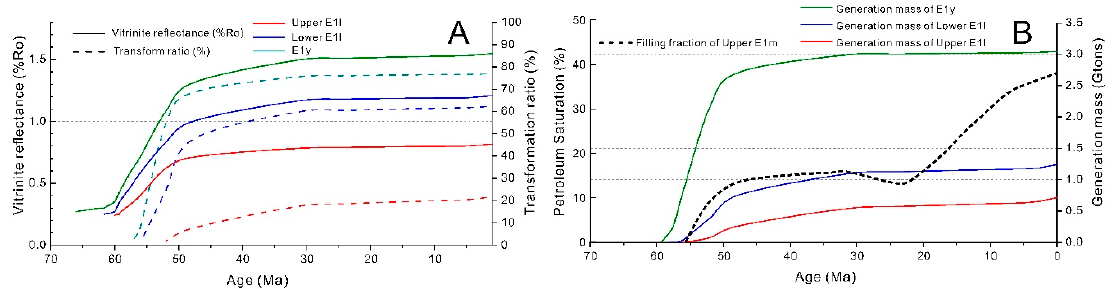
Figure 16. ( A ) Maturity evolution for each source rock according to vitrinite reflectance (solid lines) and transformation ratio (dash lines). ( B ) The bulk generation mass evolution of three main source rock: E 1 y, Lower E 1 l and Upper E 1 l (solid lines), and the petroleum filling saturation history in the Upper E 1 m for Well LS36-A (dash line).